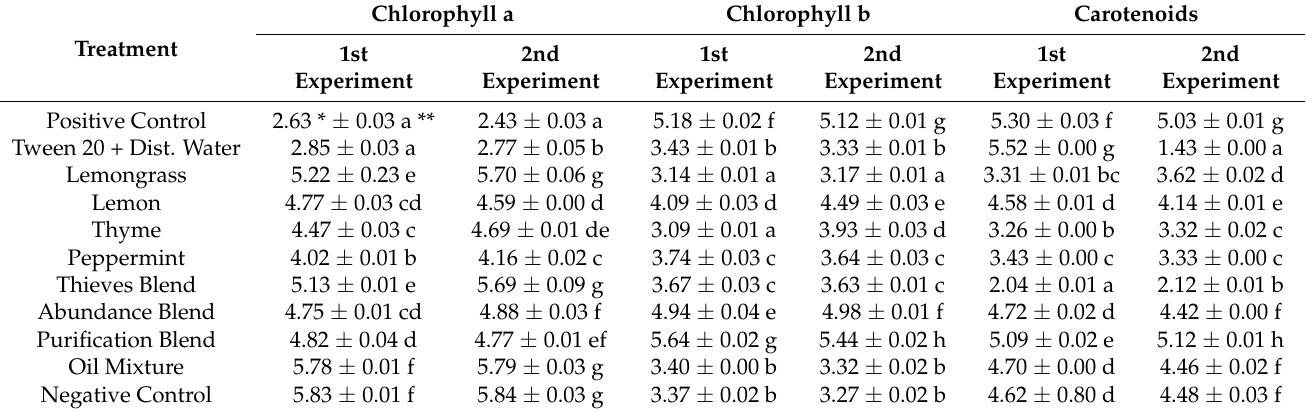
Table 4. Effect of treatment with essential oils (2.5 mL/L) on pigment formation (mg/g of fresh weight) in the cucumber plants under greenhouse conditions.